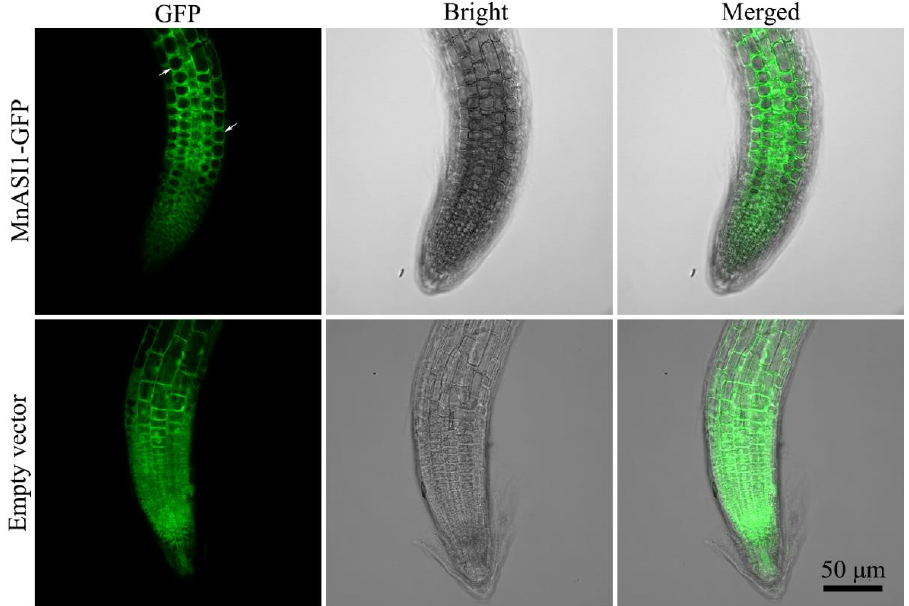
Figure 4. Image of Arabidopsis root tips producing MnASI1 -GFP fusion protein. GFP fluorescence was detected by confocal laser scanning microscopy. The arrow shows the cell membrane.